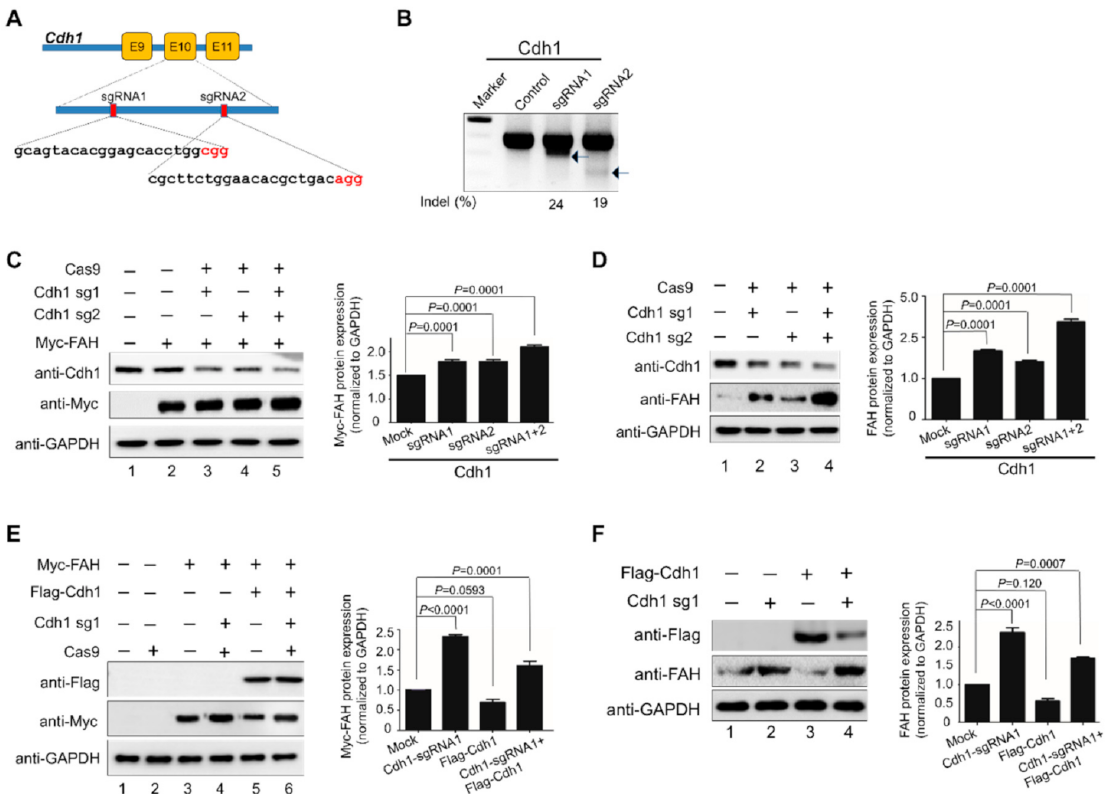
Figure 4. APC / C Cdh1 is a negative regulator of FAH protein stability. ( A ) Schematic of the RNA-guided engineered nuclease targeting the human Cdh1 gene with designed sgRNA1 and sgRNA2 that target sequences in exon 10. Yellow boxes represent exons. Red box indicates the positions of sgRNAs targeting the top strand. Target sequences are represented in black and PAM sequences are represented in red. ( B ) T7E1 assays were performed in HEK293 cells to determine the cleavage e ffi ciency of sgRNA-1 and sgRNA-2 by transfecting Cas9, sgRNA-1 and sgRNA-2. The samples were loaded in 2% agarose gel. The two bands in the sgRNA-1 and sgRNA-2 results indicate the cleaved size of DNA and are indicated by arrows along with the indel percentages measured by band intensity using ImageJ software. Untransfected HEK293 cells were used as a control. The marker is shown for size reference. ( C ) HEK293 cells were transiently transfected with sgRNA-1 and sgRNA-2 targeting Cdh1 along with ectopically expressed Myc-FAH to check exogenous protein levels. ( D ) HHSteCs were transfected with sgRNA-1 and sgRNA-2 targeting Cdh1 to check endogenous FAH protein levels using FAH specific antibody and endogenous Cdh1 was detected using anti-Cdh1 antibody. ( E ) Reconstitution e ff ect of Cdh1 on exogenous FAH protein level in Cdh1-depleted HEK293 cells. ( F ) Reconstitution e ff ect of Cdh1 on endogenous FAH protein level in Cdh1-depleted HHSteCs. The FAH band intensity for ( C – F ) was estimated by ImageJ software and normalized with GAPDH for graphical representation. Data were presented as the mean and standard deviation of three independent experiments. One-way ANOVA followed by Tukey’s post hoc test was used and p -values are